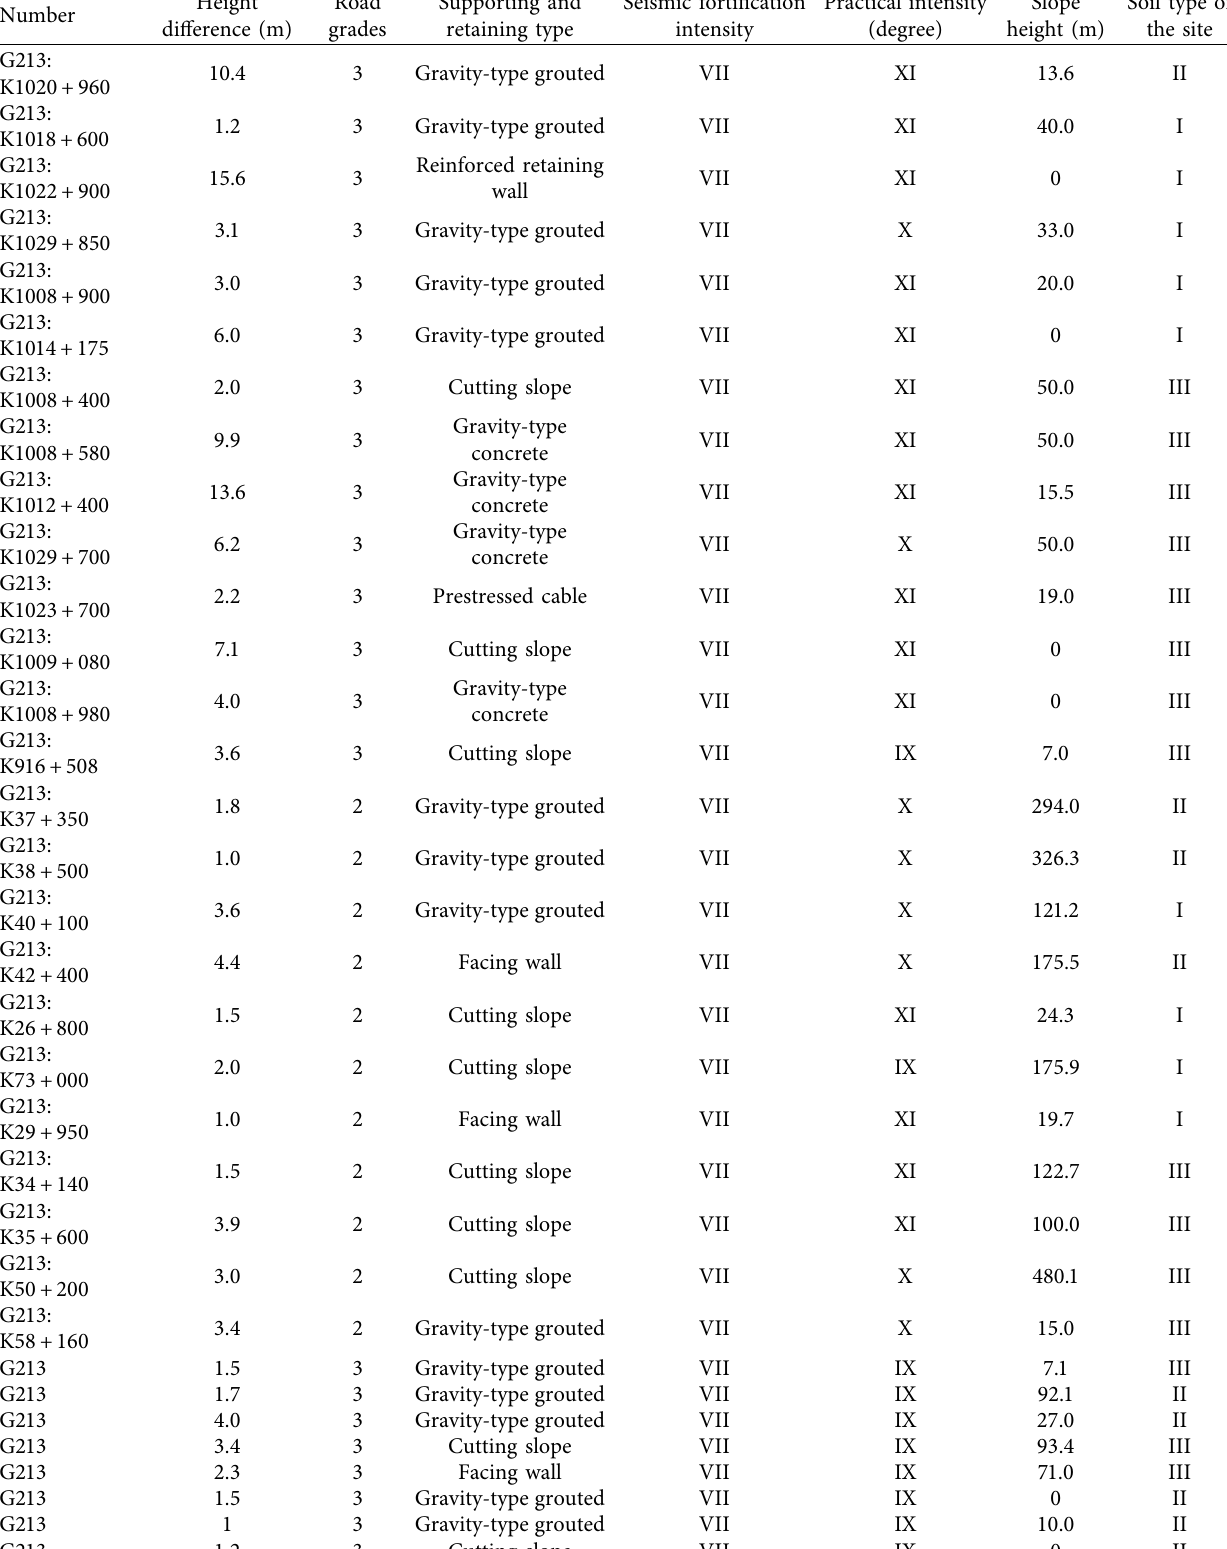
Table 1: The damage roads of the Wenchuan earthquake with some characteristics; the number consists of the road name and the mileage